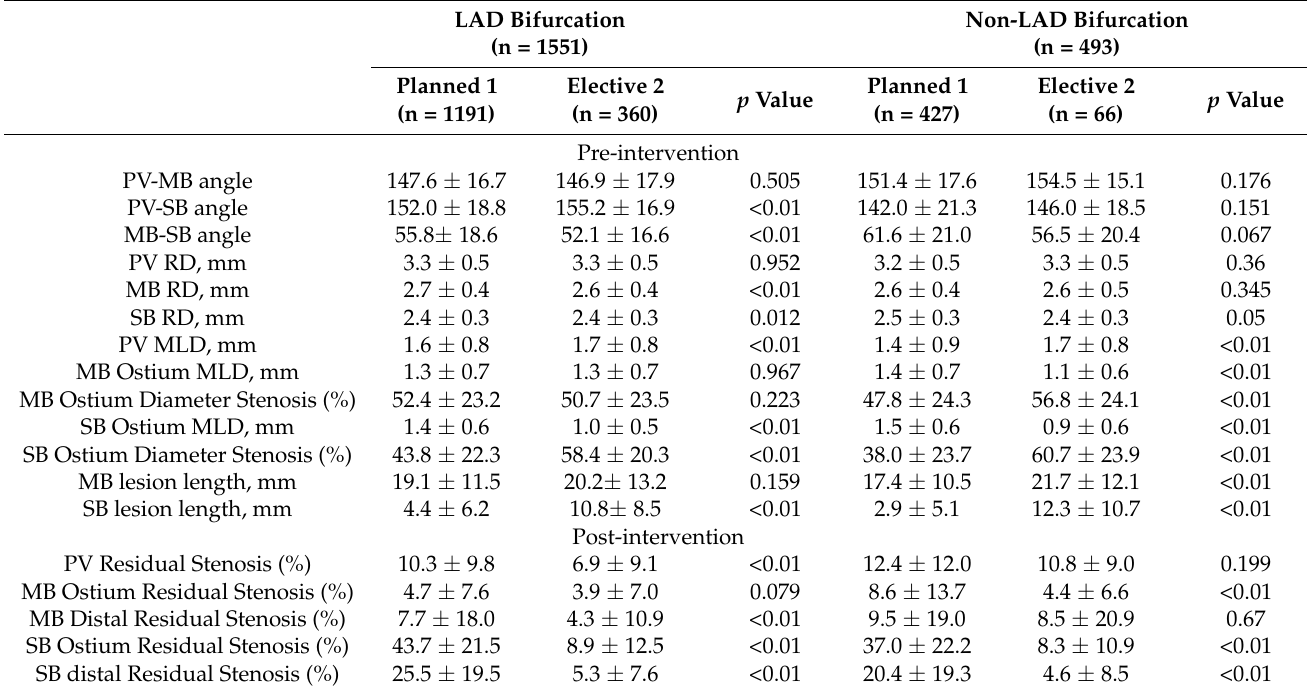
Table 2. Quantitative coronary angiographic